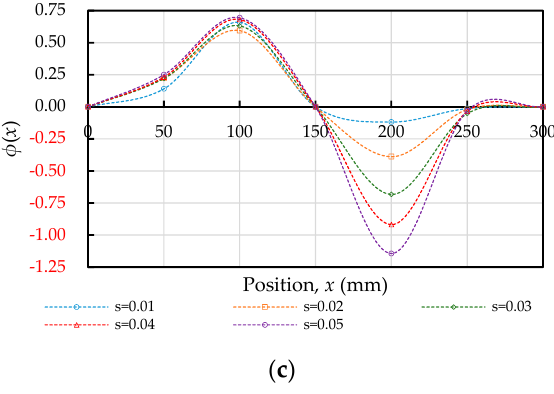
Figure 14. Position function: ( a ) C20, ( b ) C40, and ( c ) C60. The position function φ ( x ) describes the bond stiffness at different positions and is a relative function. In other words, the shape of the position function φ ( x ) is used to describe the relative magnitude of the bond strength at different positions along the steel bar. Taking the ratio ( x / l a ) of the distance from the endpoint of the specimen ( x ) to the half-length of the specimen ( l a ) as the parameter, the position function φ ( x ) and its determination coefficient were obtained by regression analysis, as shown in Figure 15. According to the concrete strength, the polynomials of the position function of each specimen are listed as Equations (20)–(22):